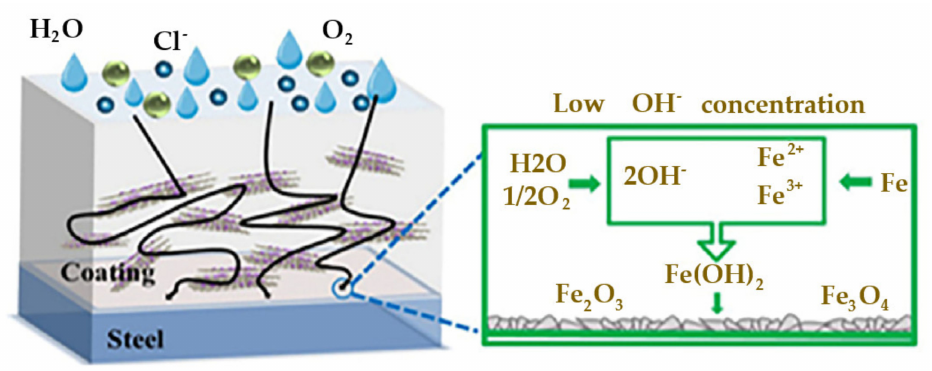
Figure 16. Schematic representation of the anticorrosion mechanism of the coating (Reproduced with permission from ref. [89]. Copyright 2020 Elsevier